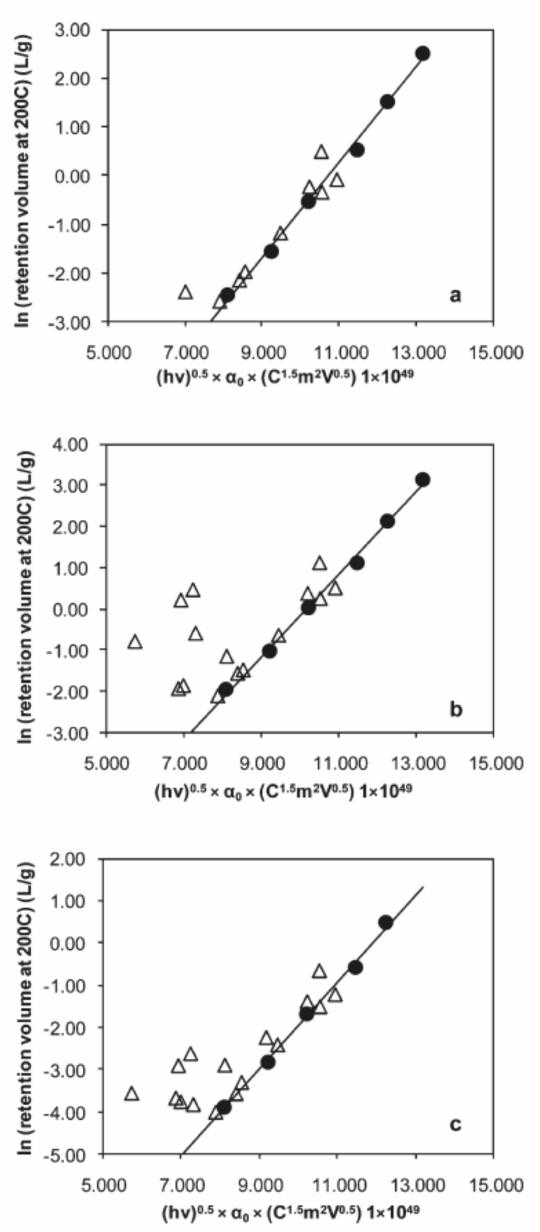
Figure 12. Correlation between a VOC deformation polarizability and the free energy of adsorption (retention volume) at 200 ◦ C as measured by IGC shown for ( a ) IRMOF-1 sample 1; ( b ) IRMOF-1 sample 2, and ( c ) IRMOF-1 sample 3. In these plots, the solid circles represent the series of n-alkanes, and the triangles represent other measured analytes. Reprinted with permission from [67]. Copyright (2010) American Chemical